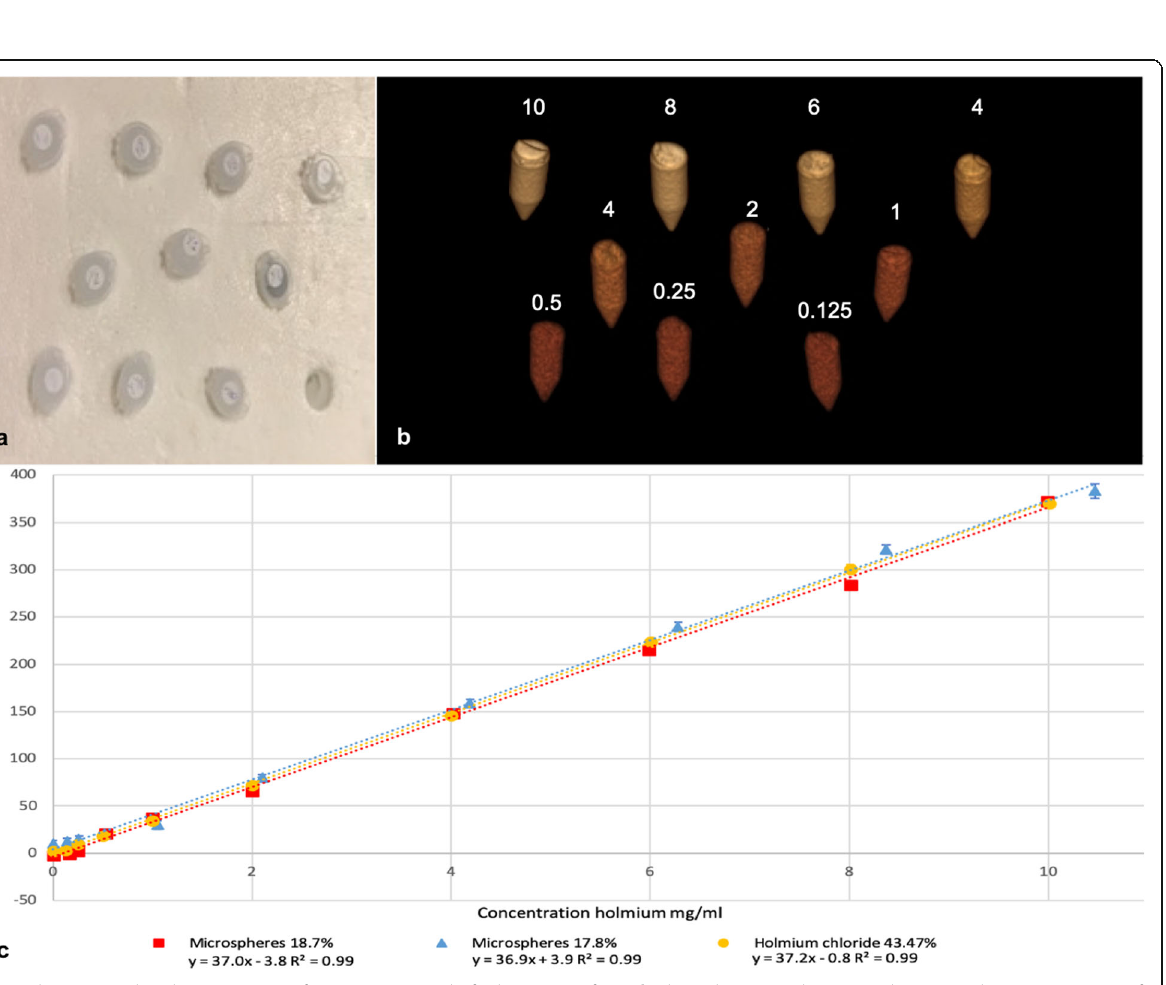
Fig. 1 Phantom. a The phantom setup of ten 5-mL Eppendorf tubes in styrofoam. b Three-dimensional computed tomography reconstruction of the phantom showing the increasing concentrations of Ho in mg/mL. c Regression slopes of HU values obtained by the calculated concentration of Ho in